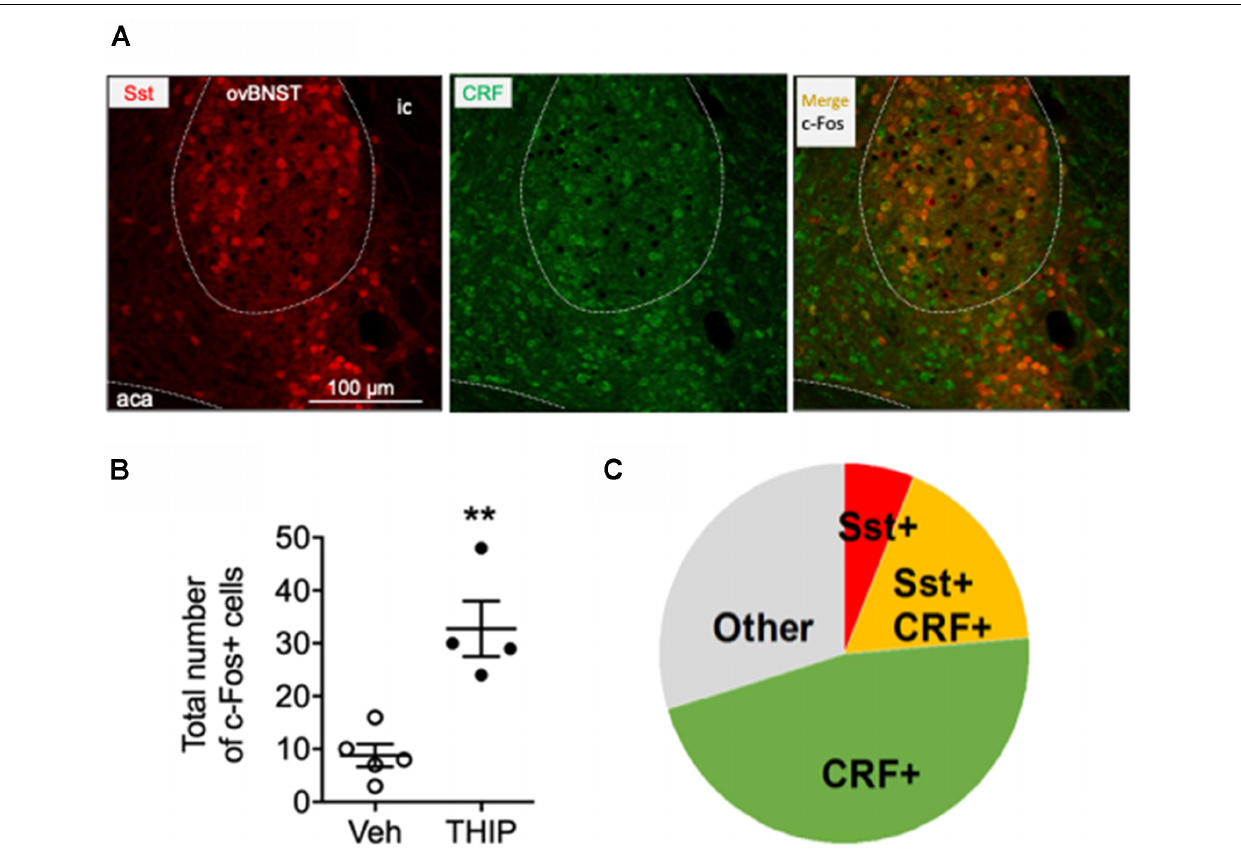
FIGURE 4 | Immunohistochemical characterization of c-Fos positive cells in ovBNST in THIP-treated mice. Immunohistochemical staining for corticotropin-releasing factor (CRF, green) in BNST sections of Somatostatin-tdTomato (red) mice revealed that 64% c-Fos-expressing cells in the ovBNST, activated by THIP treatment, also express CRF. (A) Triple fluorescence labeling of CRF (green), Somatostatin (red, Sst) and c-Fos protein (black nuclei) in the ovBNST at high magnification. Scale bar: 100 µ m. aca, anterior commissure; ic, internal capsule. (B) In line with the previous experiment ( Figure 3 ), THIP induced a robust c-Fos activation in the ovBNST. The total number of c-Fos+ cells in the ovBNST are given as individual data points with means ± SEM, n = 5 and 4 mice treated with saline vehicle (Veh) and THIP, respectively; ∗∗ p = 0.01 ( t -test). (C) A pie chart representing the fractions of CRF/c-Fos+ (green), Sst/c-Fos+ (red), CRF/Sst/c-Fos+ (orange) and non-identified c-Fos+ (gray) cells in THIP-treated mice ( n =